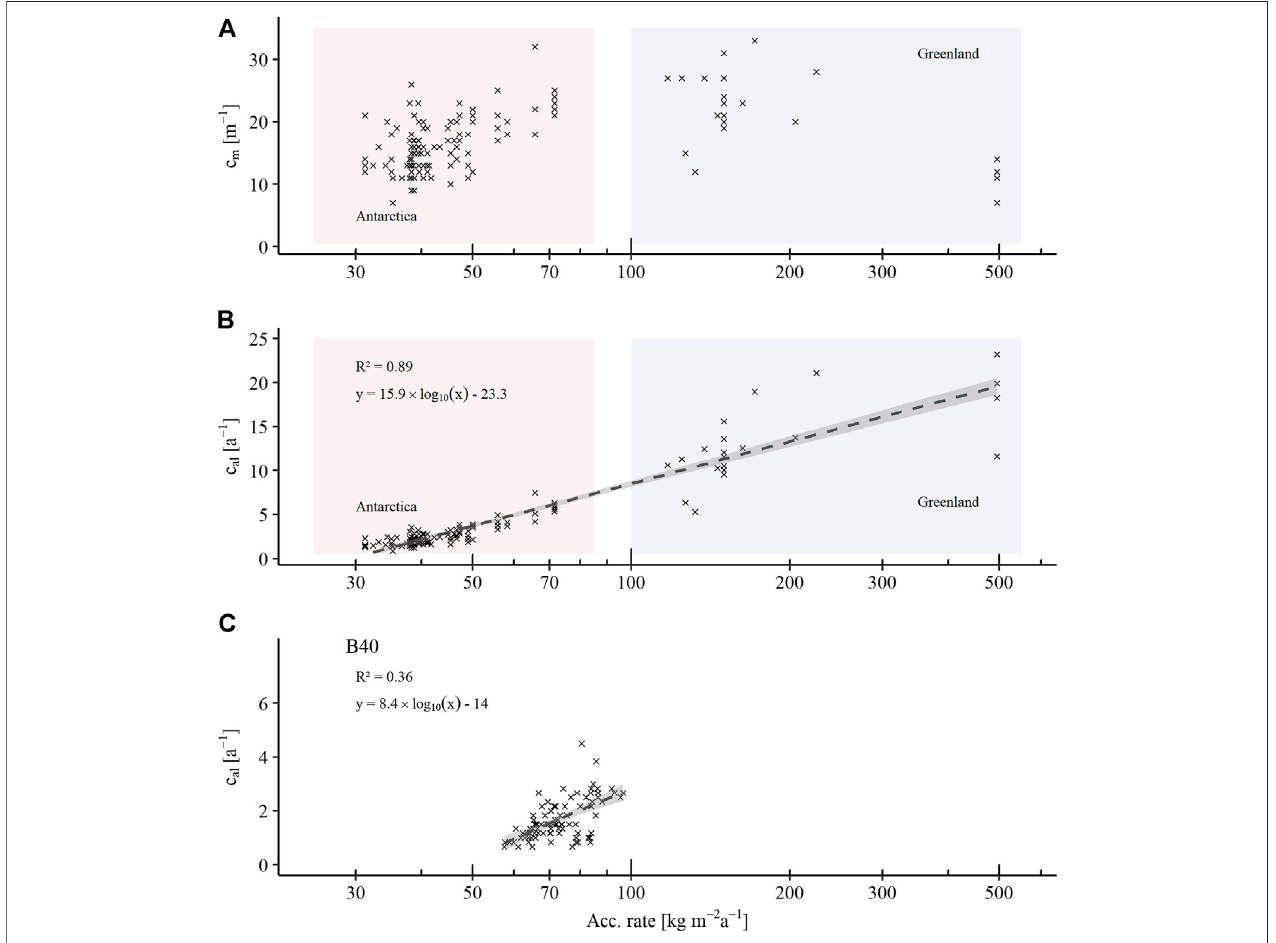
FIGURE6| (A) and (B) : Spatial crust statistics forAntarcticaand Greenland. We used thecrust information insnow ofthe topmeterat all samplingsites. In (A) the crust concentration, in (B) the crust concentration per annual layer isplotted against the accumulation rate (logarithmic scale) at each sampling position. With increasing accumulation rate, also the number of crusts per year increases (C) : Five-year running mean of crust concentration per annual layer, also plotted against the accumulation rate (logarithmic scale), in fi rn core B40 (up to 15 m depth) over the last 100 years at Kohnen Station. It shows the temporal evolution of crusts with changing accumulation rate, possibly affected/biased by the destruction of crusts through metamorphism with depth (and time).